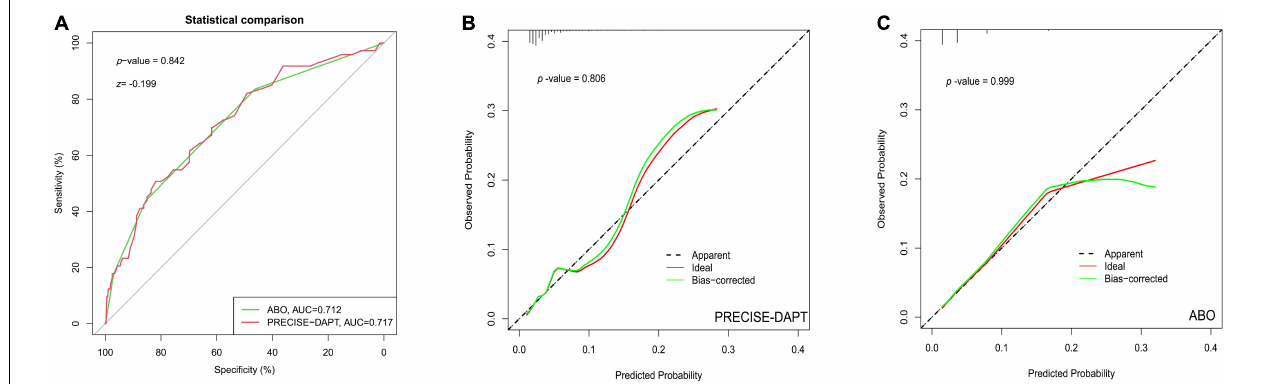
FIGURE 2 | The performance of receiver operating characteristic (ROC) curve and calibration plot for PRECISE-DAPT and ABO risk score systems in overall patients with 1-year DAPT after PCI. (A) ROC curve for the prediction of BARC ≥ 2 type bleeding events by PRECISE-DAPT and ABO risk score systems in overall patients with 1-year DAPT after PCI [AUC: 0.717 and 0.712, respectively; (95% CI, 0.656–0.777)and (95% CI, 0.650–0.774), respectively; p < 0.001]. The C-statistics for the two risk models were compared to each other by the DeLong test ( z = –0.199, p = 0.842). (B) The calibration plot for PRECISE-DAPT risk score in overall patients